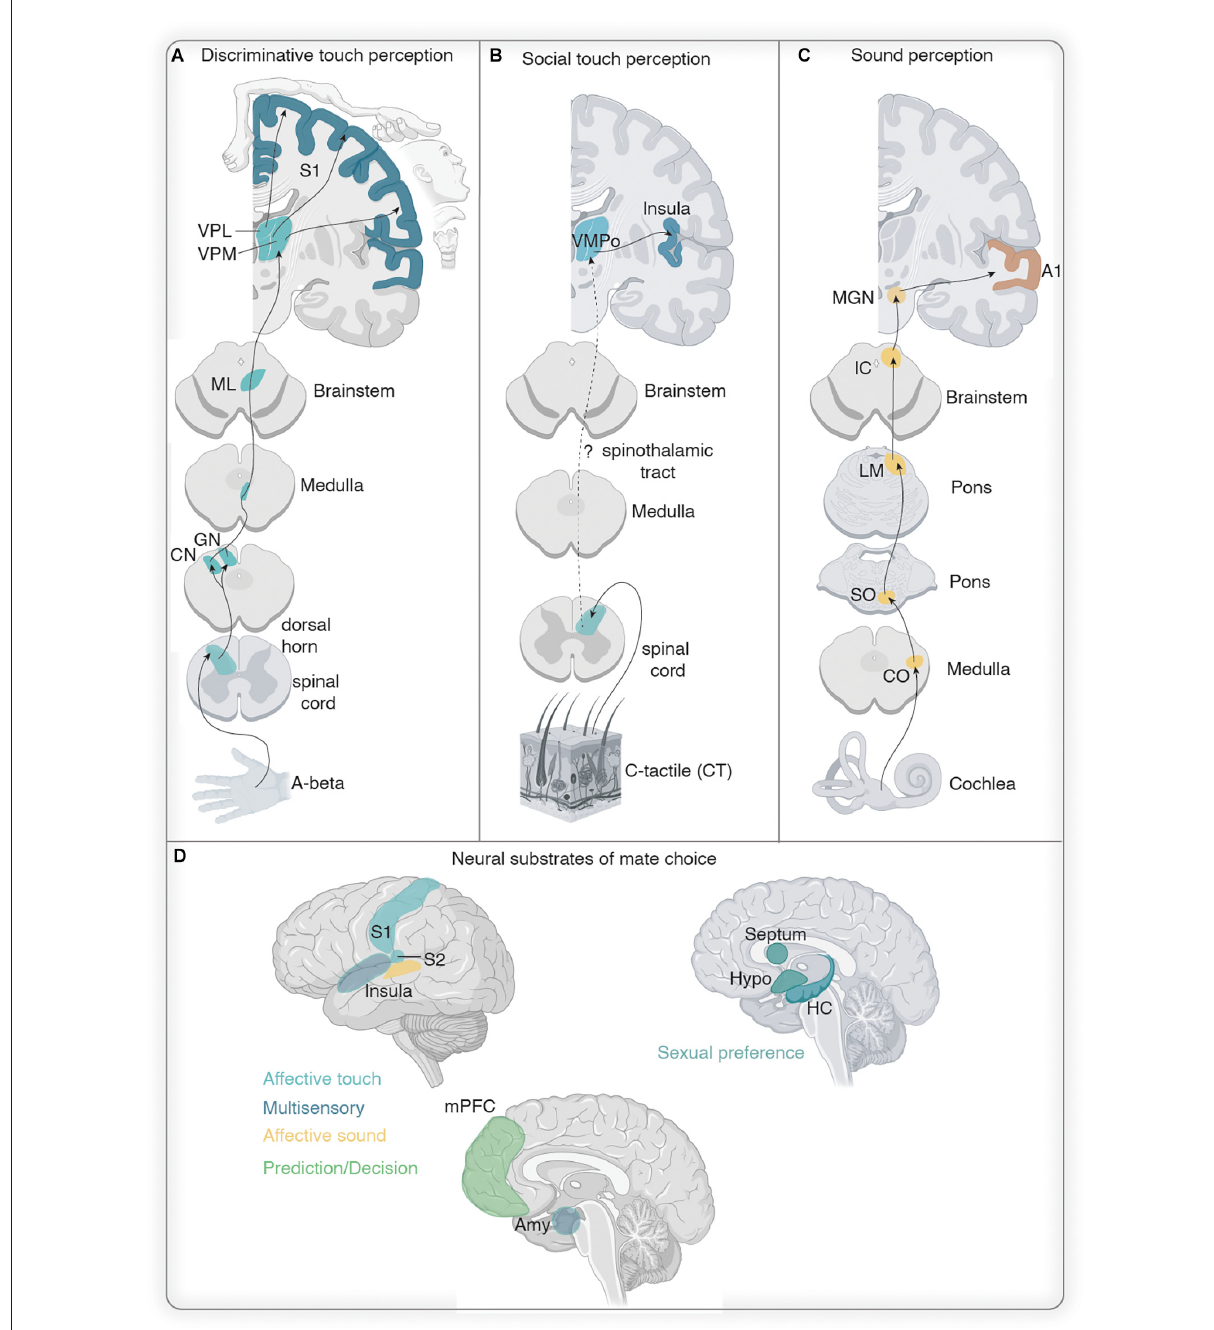
FIGURE4 Neural circuits for audition and somatosensation in the context of human mate choice. (A) Discriminative touch is thought to be relayed to the dorsal spinal cord via A-beta fibers primarily found in glabrous skin. Touch information is then sent to the cutaneous nucleus (CN) and gracilis nucleus (GN) and travels further through the medulla and mediolateral brainstem before being relayed by the thalamus (ventral posterolateral, VPL, and ventral posteromedial, VPM nuclei) towards the primary somatosensory cortex (S1) which contains a topography of the outer body, known as the homunculus. (B) Social touch is predominantly transmitted via C-tactile (CT) fibers to the dorsal spinal cord. The ascending route through the medulla and brainstem is not unraveled. Social touch is thought to be primarily relayed via the ventromedial part of the posterior thalamus(VMPo)towardstheinsularcortex. (C) Thesoundperceptionpathway.Auditoryinformationisperceivedbythecochlearwhichtransmits the information via the cochlear nerve to the cochlear nucleus (CN) from where is sent to the superior olive (SO) and further through the nucleus of the lateral lemniscus (LM) to the inferior colliculus (IC) in the brainstem. The medial geniculate nucleus (MGN) is the thalamic relay station from which information is sent to the primary auditory cortex (A1). (D) Potential neural substrates of human mate choice. Brain, spinal cord, hand, skin, and cochlea icons were created with